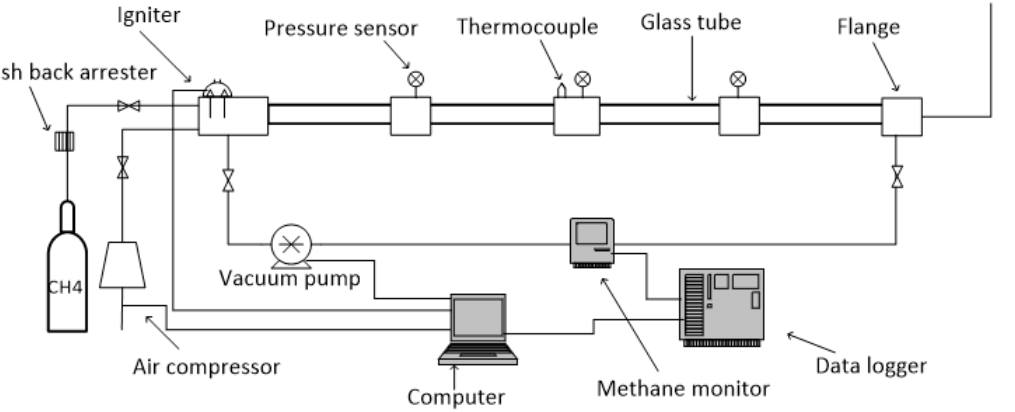
Figure 1. Schematic diagram of the experimental setup.